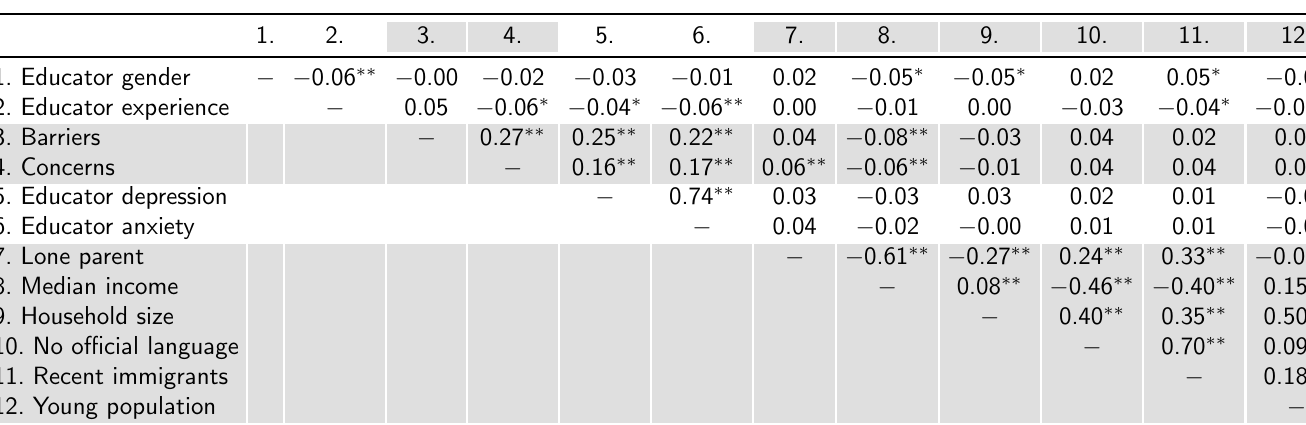
Table 5: Bivariate correlations of all study variables. Shading separates categories of variables (respondent demographics, reported barriers and concerns, educator mental health, school neighbourhood SES)